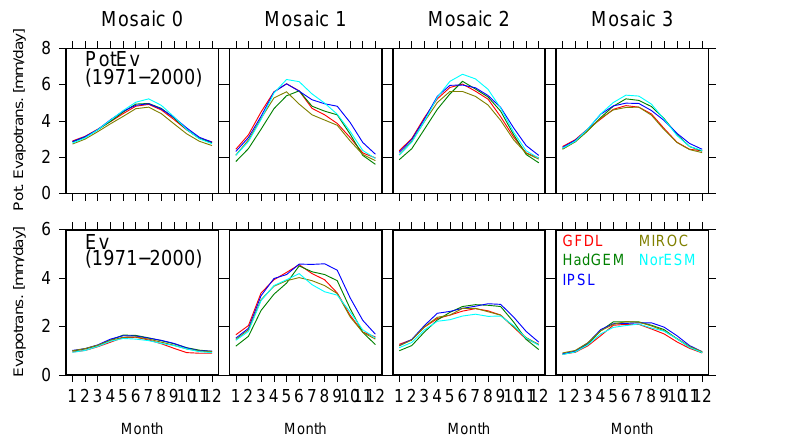
Figure 3. Monthly profiles of the potential evapotranspiration and evapotranspiration for 1971–2000 calculated in this study. The results are aggregated over the same land use. Profiles of the five GCMs are indicated in different colors: (red) GFDL, (green) HadGEM, (blue) IPSL, (dark yellow) MIROC and (light blue) NorESM.